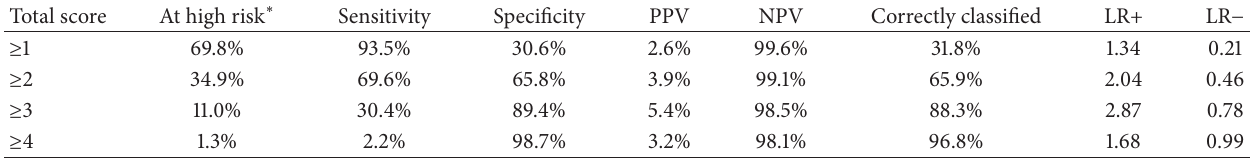
Table 3: Performance of different cut-points for detecting undiagnosed type 2 diabetes in the development database.